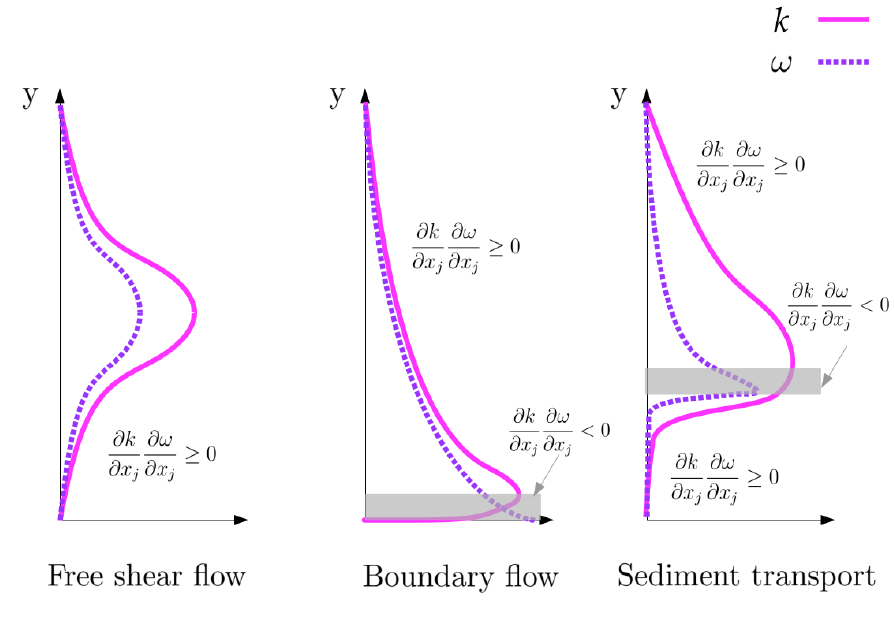
Figure 8. Typical turbulent kinetic energy ( k ) and specific dissipation rate ( ω ) profiles for free shear flows, boundary flows, and sediment transport